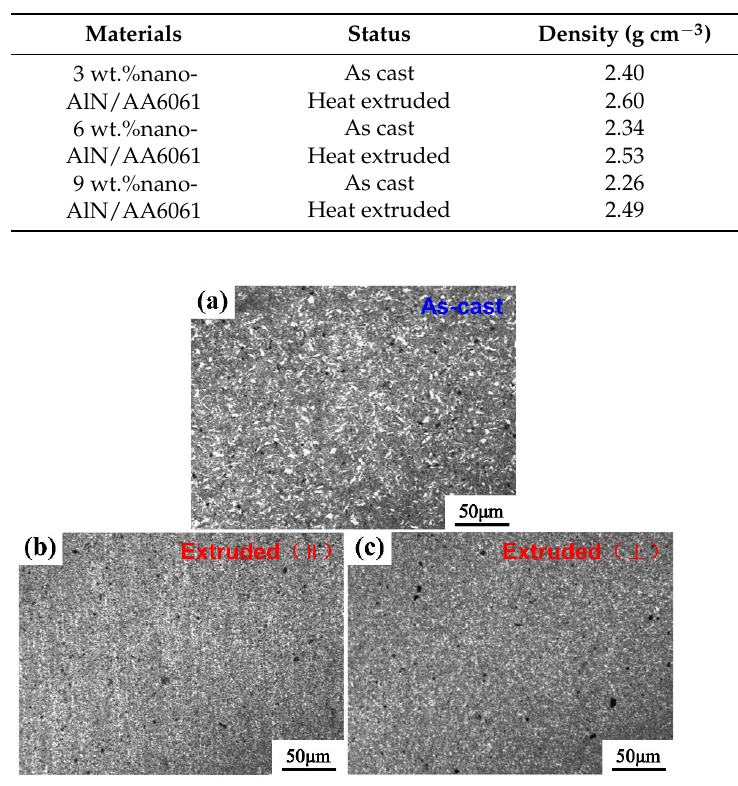
Figure 4. SEM images of nano ‐ AlN/AA6061composite: ( a ) as ‐ cast; ( b,c )after HE(the extrusion direc ‐ tion is marked in the figure). direction is marked in the